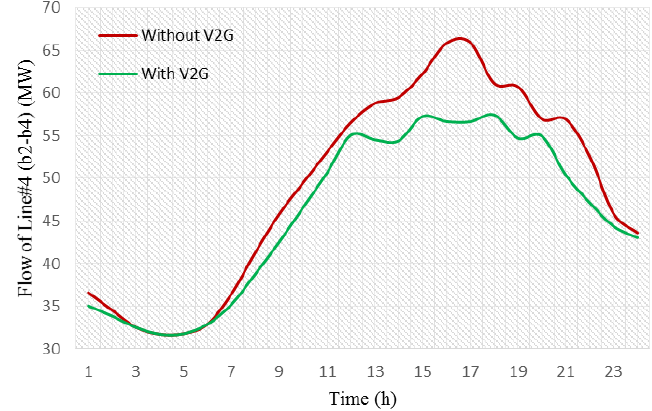
Figure 7. The power flow in line 4 for both cases: with and without V2G.